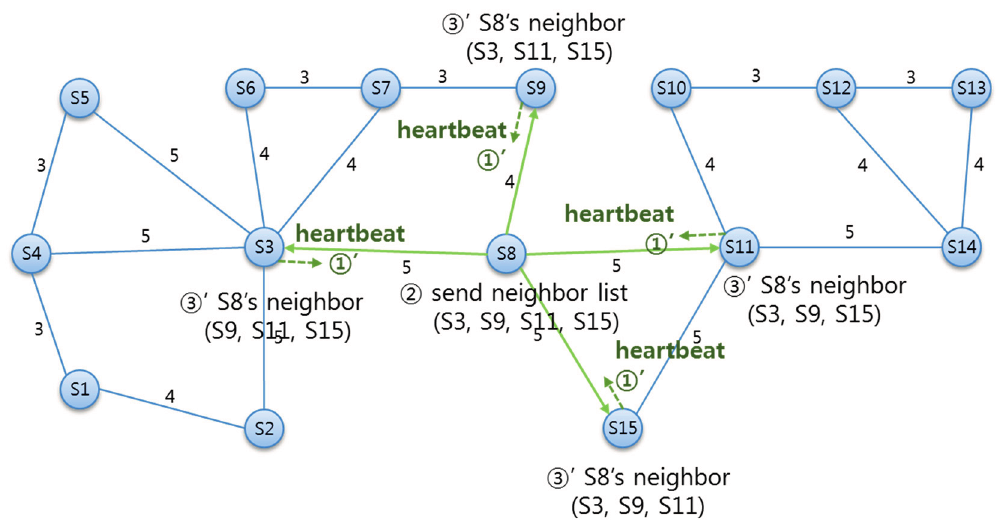
Figure 11. The periodic heartbeat process to check for a deleted SLiM Hub.